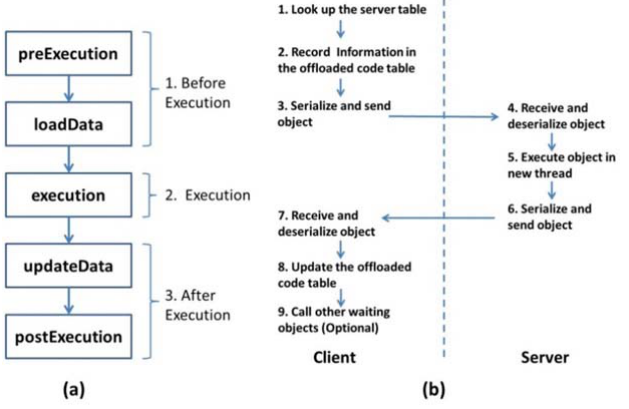
Figure 4: (a) Life of a remotable object is divided into three stages by im- plementing the RemotableTask interface (b) Code offloading workflow The Jade optimizer considers all remotable objects of an application for offloading. If a remotable object is eligible for offloading, the Jade runtime engine handles the code offload- ing by following the workflow shown in Figure 4.